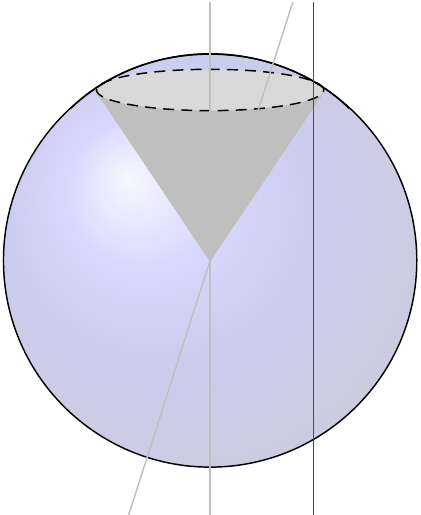
Figure 1 . Three cosmic strings: a string passing though the north pole of the sphere; a string rotated with respect to this axis and a third string (red) translated with respect to the (cid:12)rst